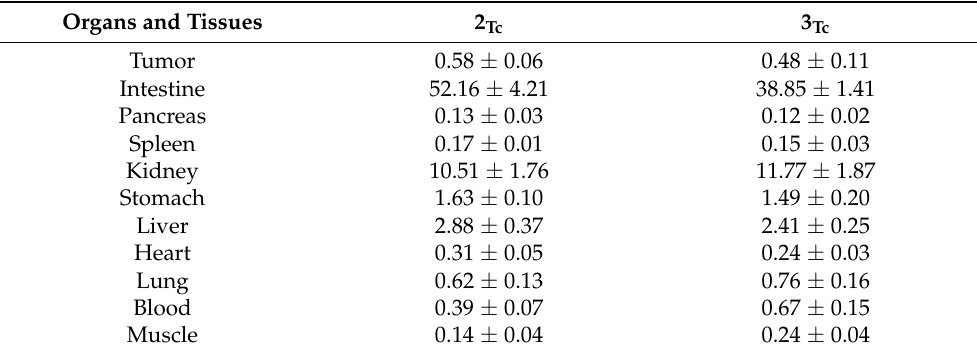
Table 1. Biodistribution results of complexes 2 Tc and 3 Tc in athymic mice bearing a SKOV3 tumor at 4 h